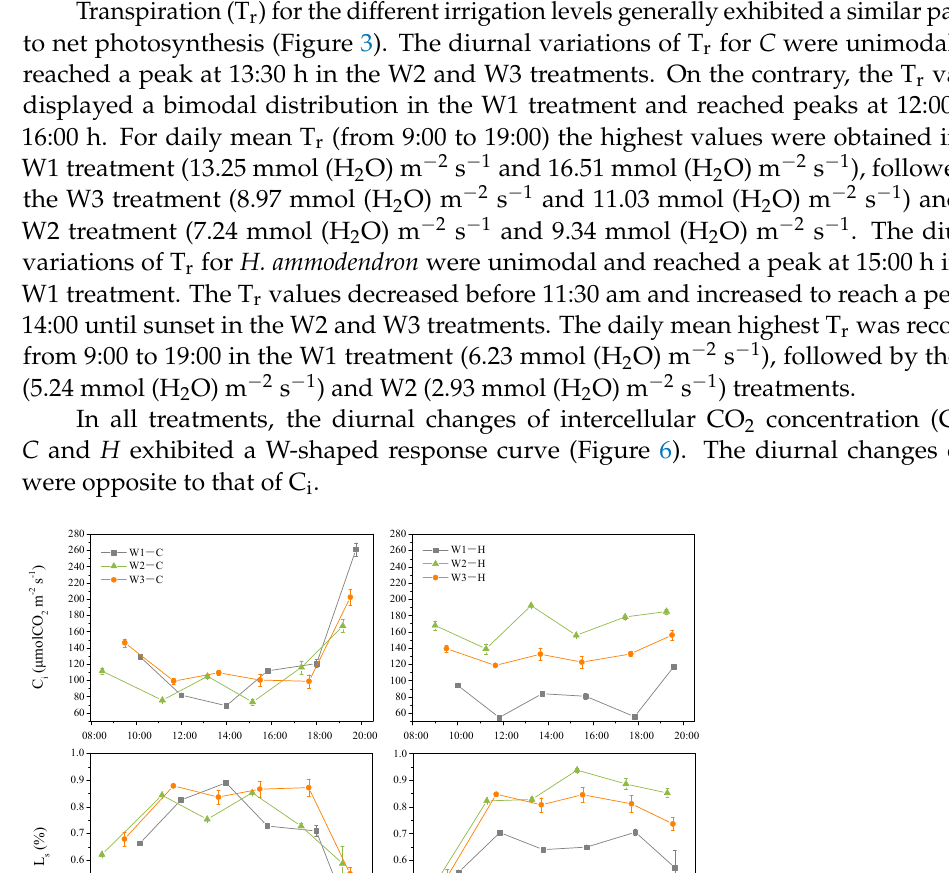
10:00 12:00 14:00 16:00 18:00